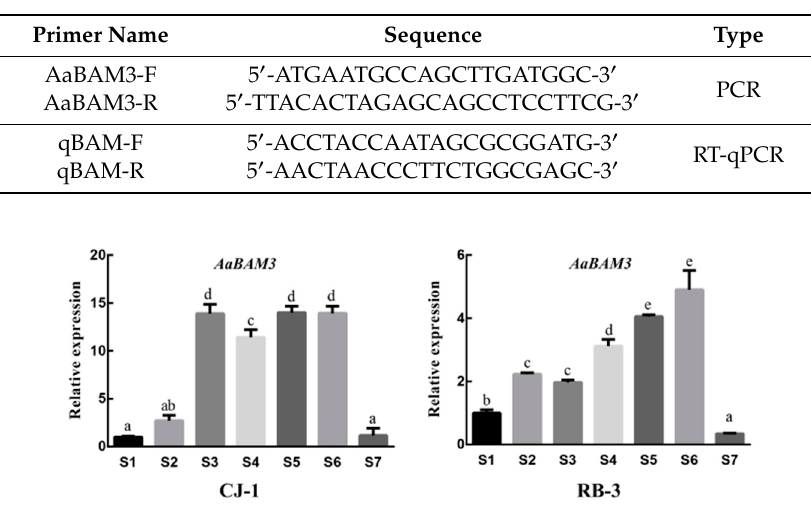
Figure 8. Seasonal changes in the relative gene expression of AaBAM3 in the shoots of “CJ-1” and “RB-3” kiwifruit cultivars. All values were normalized to the expression levels of β -ACTIN housekeeping gene. Data were presented as means ± standard errors ( n = 3). Table 3. The sequences of primers used in this paper.